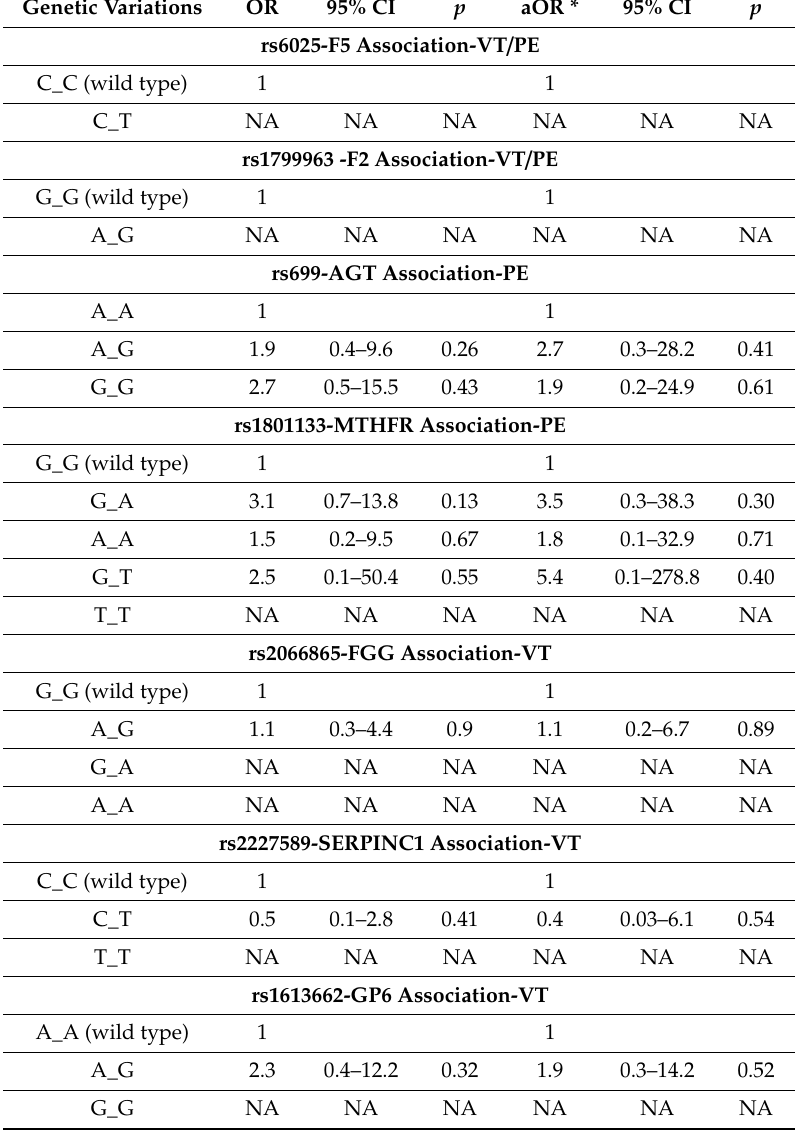
Table 5. Association between polymorphisms and abnormal a.uterina flow in univariate and multivariate